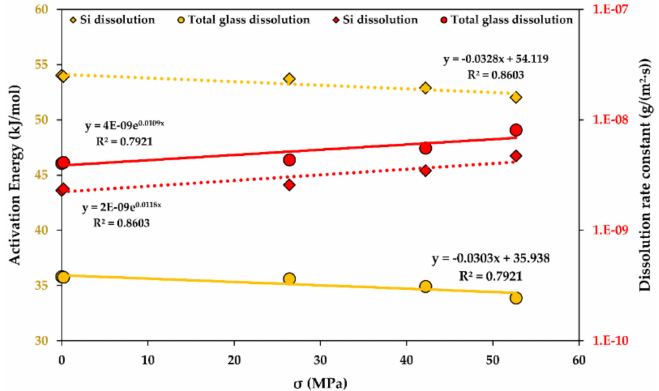
Figure 9. The activation energy of dissolution (yellow) and the dissolution rate constants (red), functions of the stress ( σ ) for the glass fibre bundles at the steady-state. Determination coefficients R 2 are shown. 4E-9 stands for “4 × 10 − 9